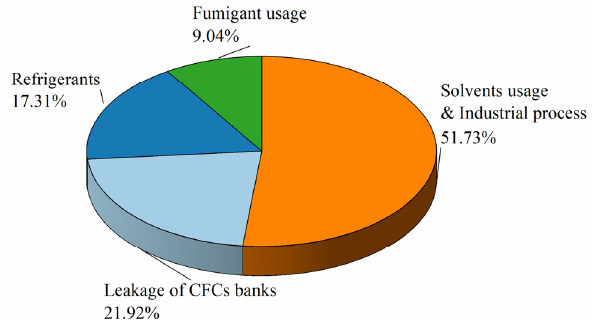
Figure 10. Source contributions to the total volatile halogenated hydrocarbons in ambient air in the study area.